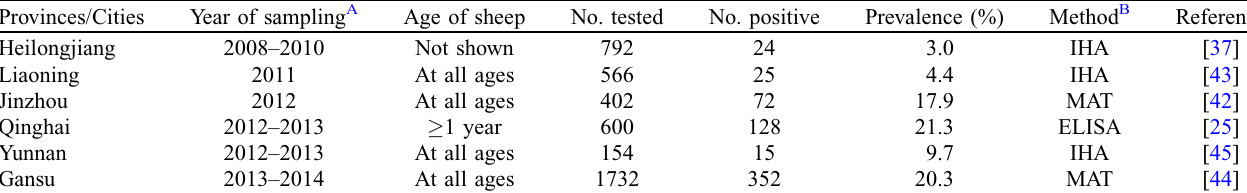
Table 1. The prevalence of Toxoplasma gondii infection in sheep in the People’s Republic of China.